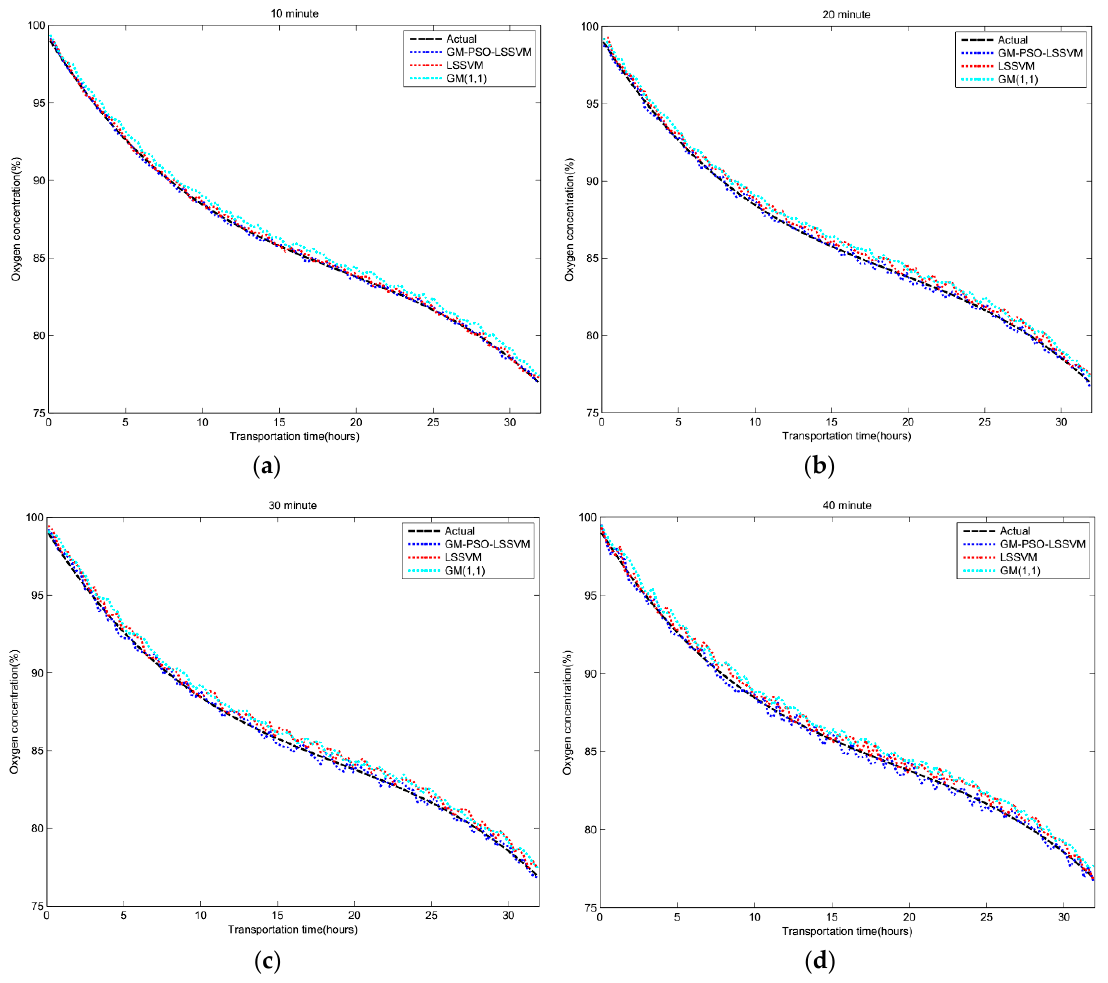
Figure 7. Forecasting model comparison with different predicted time length. ( a ) 10 min; ( b ) 20 min; ( c ) 30 min; ( c ) 40 min. Table 3. Forecasting execution time in different predicted time length (unit: